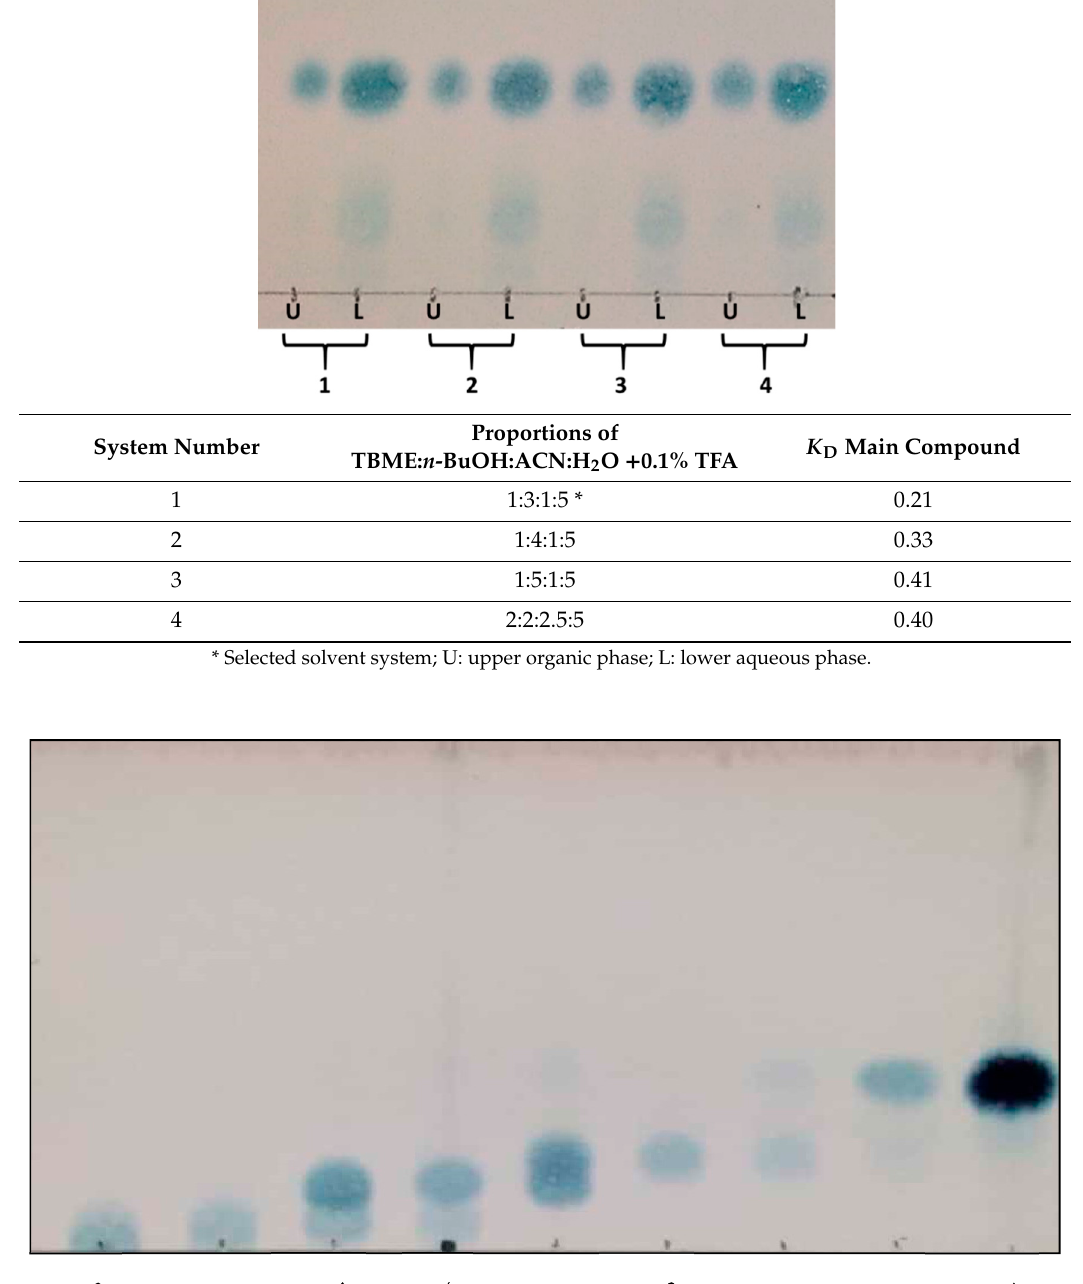
Table 1. Summary of the partition ratios ( K D ) values of biphasic solvent system (TBME / 1-BuOH / ACN / H 2 O) for the main compounds in the Sephadex 8–15 fractions from the hydroalcoholic stem extract of Adenocalymma marginatum .